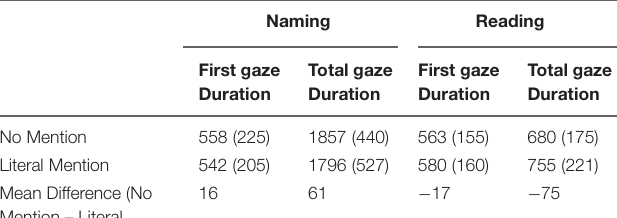
TABLE 2 | Mean first and total gaze durations on object character/word in ms (and standard deviation) per condition in Naming (Experiment 1), in Reading (Experiment 2) and the mean difference across conditions (No Mention – Literal